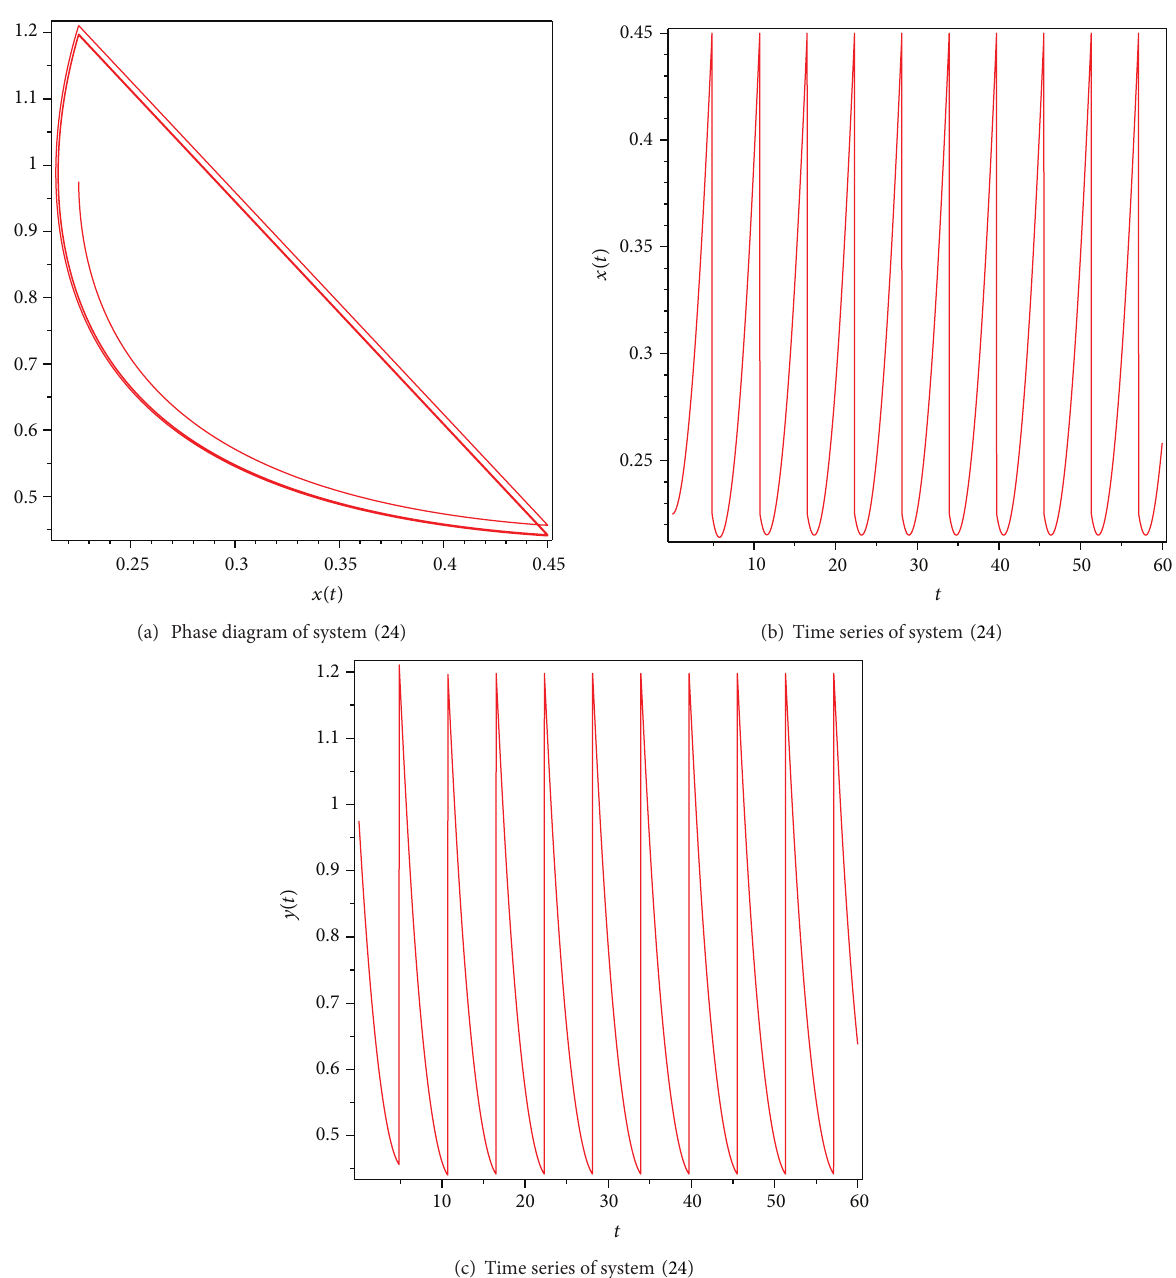
Figure 20: Illustration of basic behavior of system